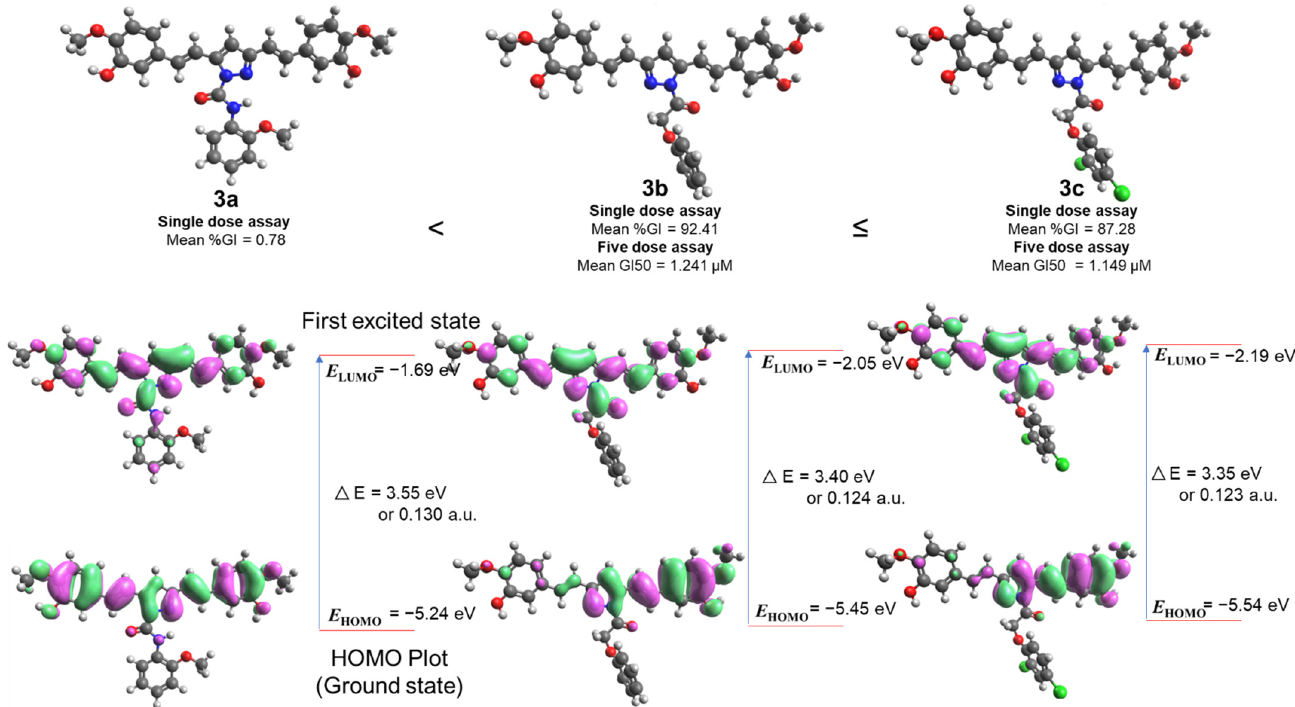
Figure 3. DFT-optimized structures, HOMO/LUMO visualization, anticancer activity and DFT correlation of compounds 3a–c.